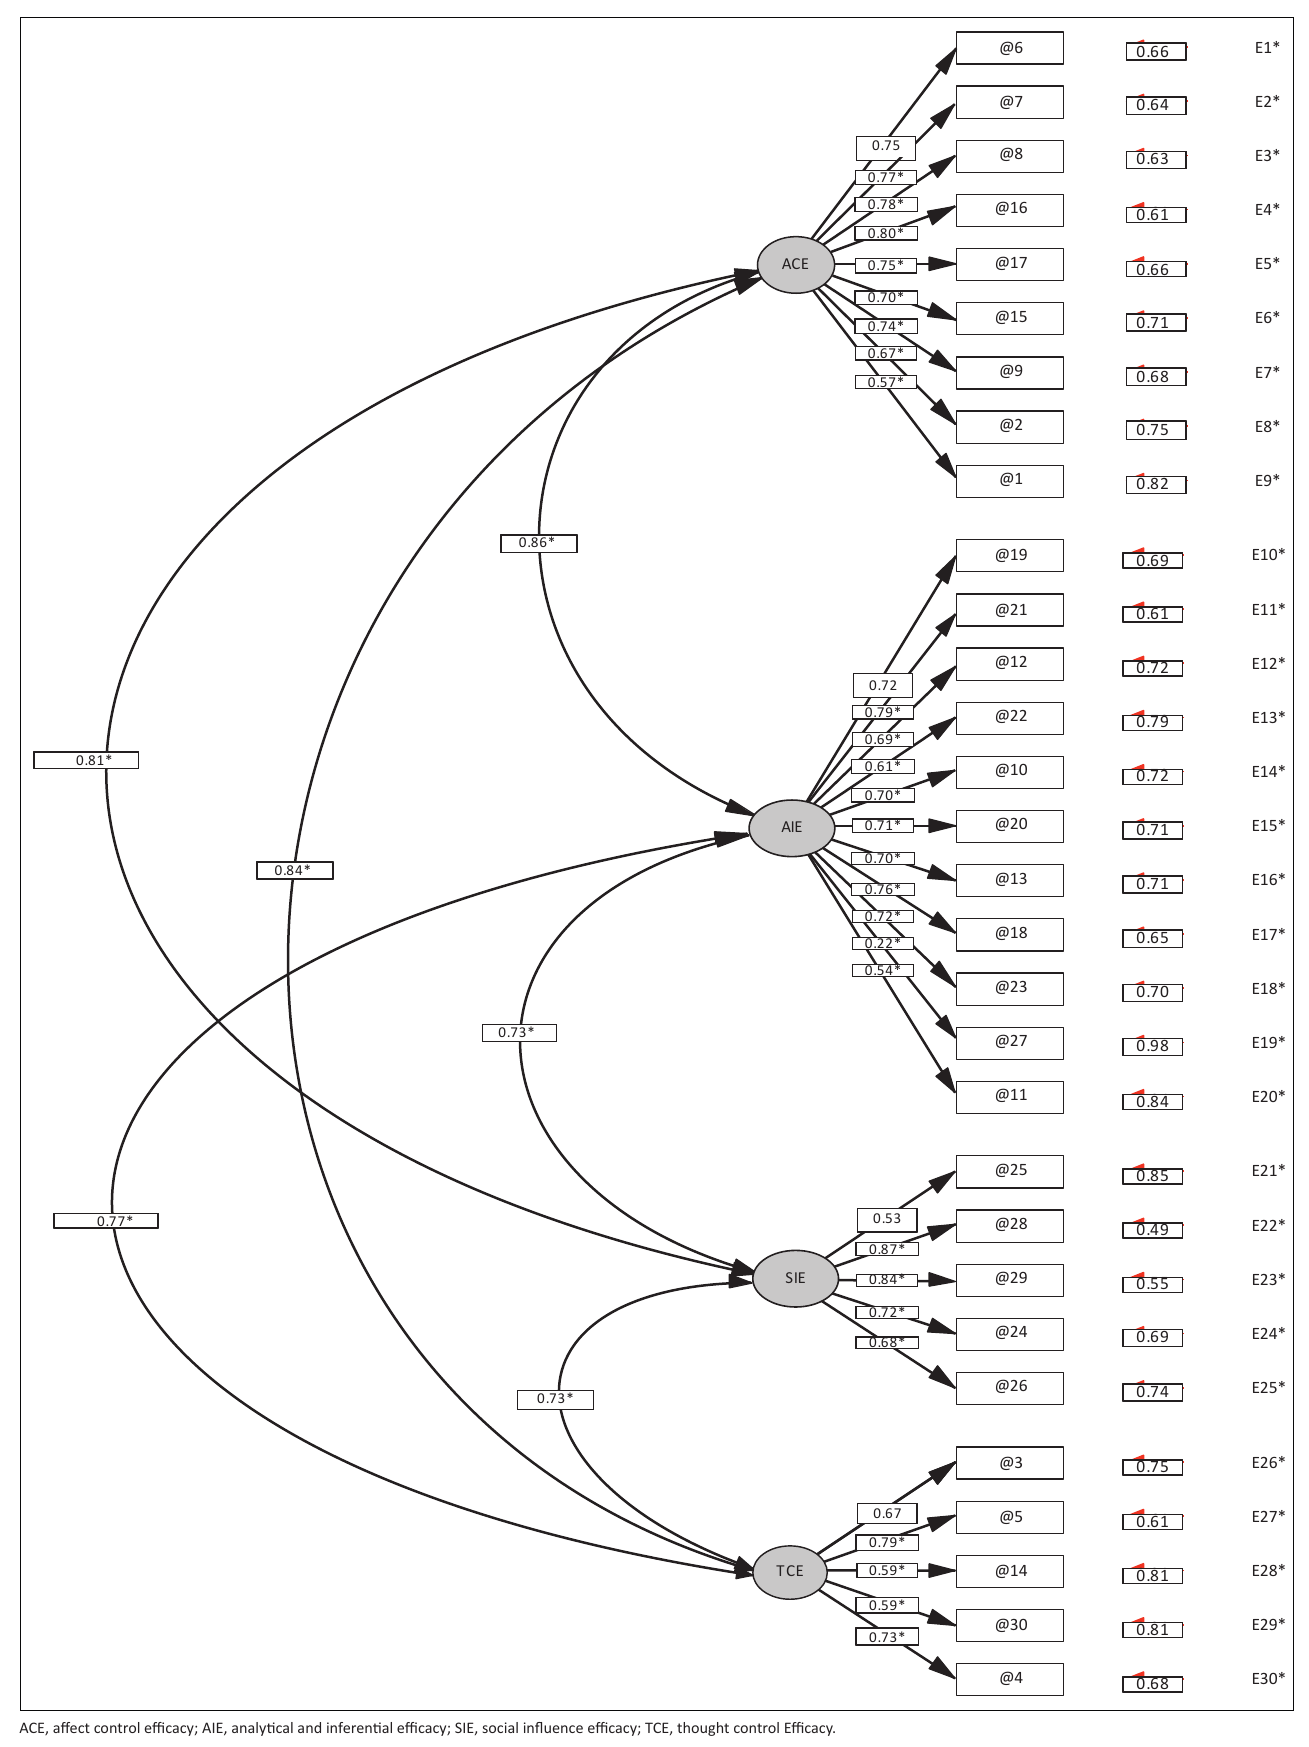
FIGURE 3: Factor standardised loadings and measurement errors of the